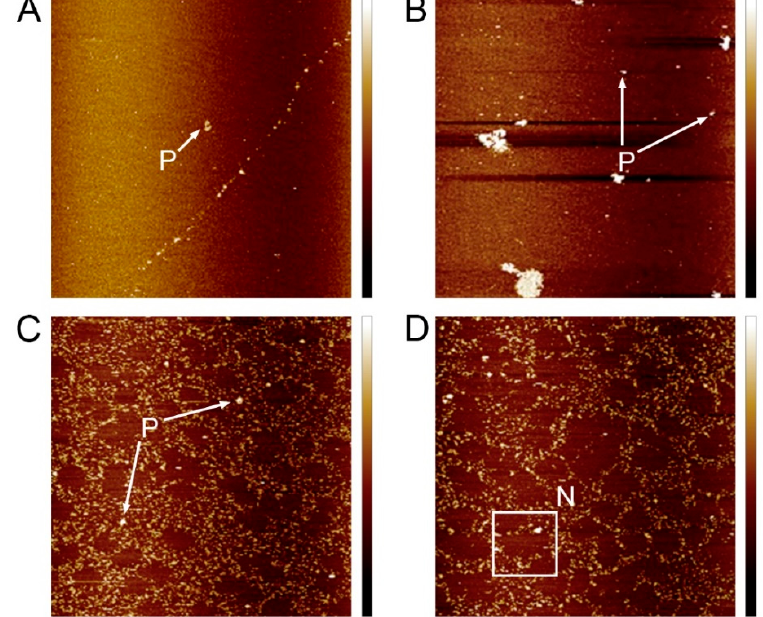
Figure 5. Atomic force microscopy images of raspberry fruit of the control ( A ), CaCl 2 ( B ) and CaCl 2 +PME ( C , D ) treatments stored at 4 °C for 9 days. Scan area: 10 × 10 μ m; P: polymer structure; CaCl 2 +PME ( C , D ) treatments stored at 4 ◦ C for 9 days. Scan area: 10 × 10 µ m; P: polymer structure; N: net ‐ linked structure. N: net-linked